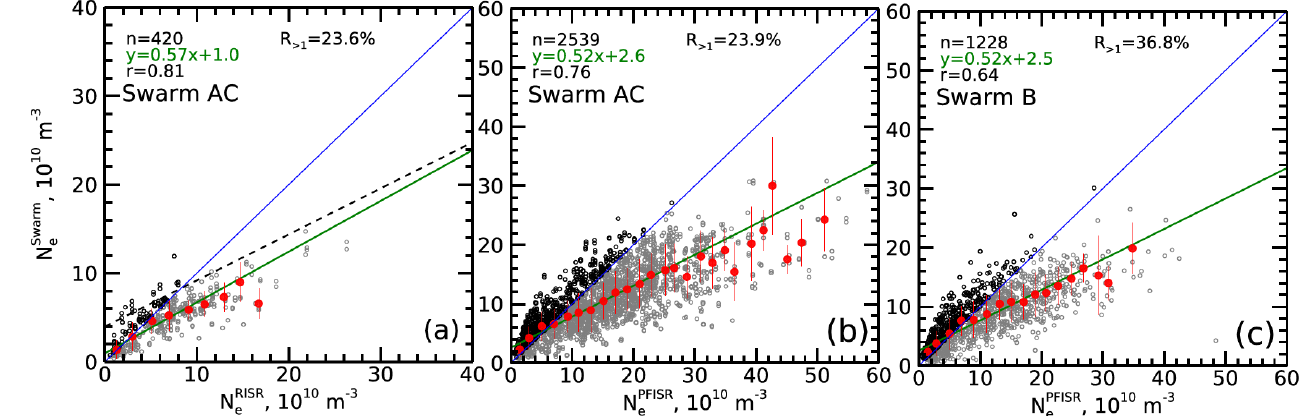
Figure 4. ( a ) Electron densities measured onboard the Swarm AC satellites versus electron densities measured by the Resolute Bay incoherent scatter radar RISR ‐ C. Darker circles reflect measurements with N eSwarm / N eRISR > 1. Red solid dots are medians of N eSwarm in bins of N eRISR (size of the bin is 2 × 10 10 m − 3 ). Vertical red bars are the binned values of N eSwarm +/ − one standard deviation of N eSwarm . The green line is a linear fit line. The dashed line is a linear fit line reported by Larson et al. [36]. ( b ) The same as ( a ) but for the Swarm AC conjunctions with PFISR. ( c ) The same as ( b ) but for the Swarm B conjunctions with PFISR.